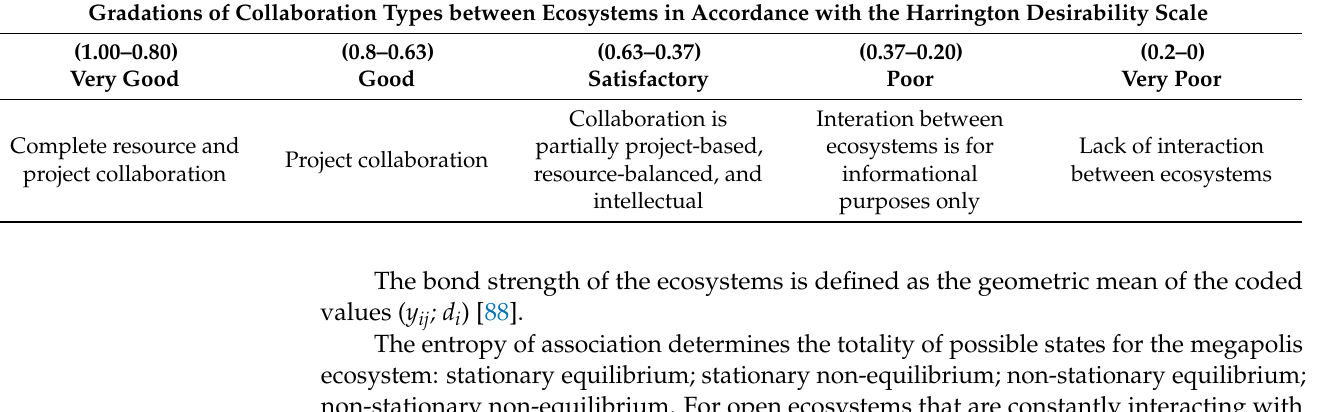
Table 3. Modified Harrington desirability